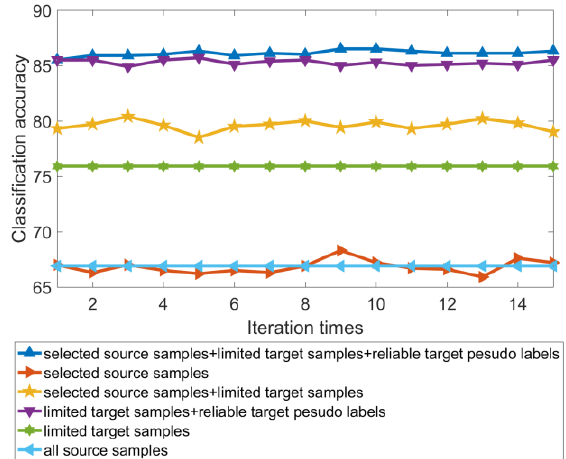
Figure 16. The experimental results of ResNet-101 architecture with 5% training ratio.